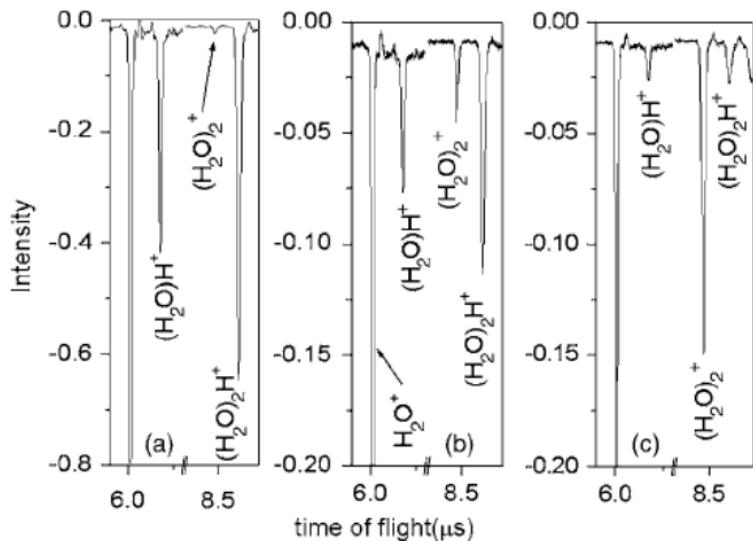
Figure 18. TOF mass spectra of unprotonated water dimer ion formed in different carrier gases: ( a ) pure He gas, ( b ) 5% Ar mixed in He gas and ( c ) 20% Ar mixed in He gas, respectively. Figure adapted from [56] with permission. Copyright 2006 American Institute of Physics.